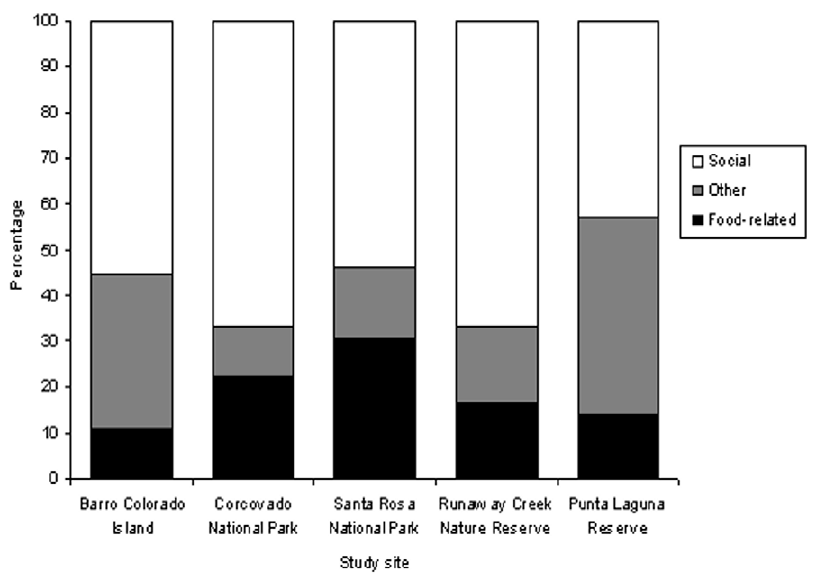
Figure 2. Percentage of behaviors, which met criteria for traditions, belonging to the three domain categories (social, food-related and other) at each site. See Table S1 for the division of the 22 traditions into the three domains and Figure 1 for the traditions at each site.